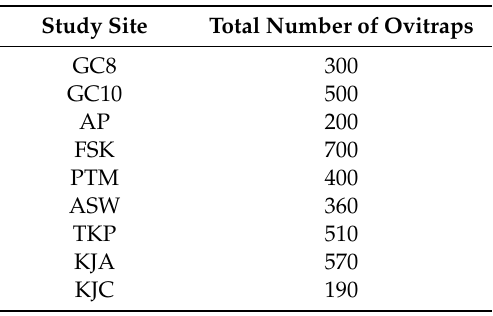
Table 1. The total number of ovitraps placed in each study site.